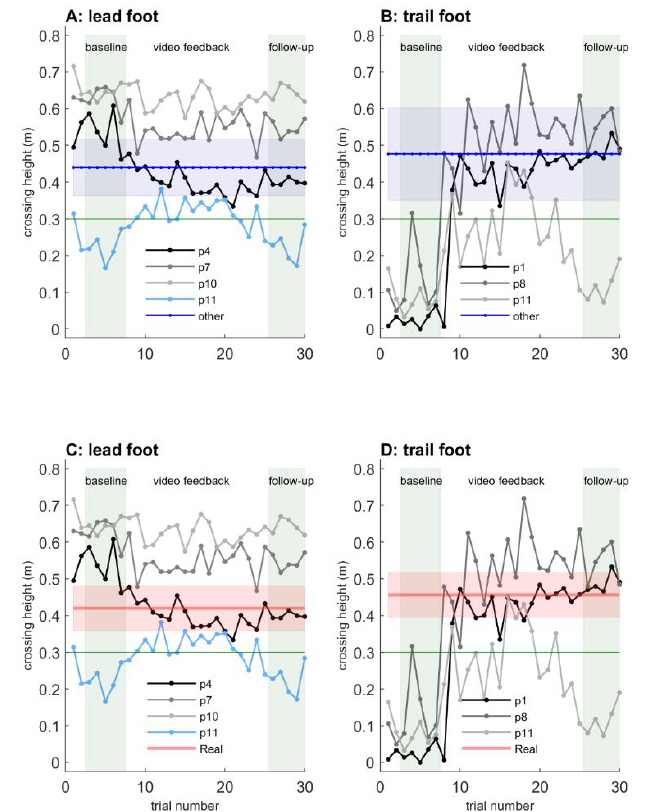
Figure 8. Crossing heights for lead ( A and C ) and trail ( B and D ) foot at holographic hurdle 1 (0.3 m height, marked as horizontal green line), focusing on the participants identified in Experiment 1 with dissimilar crossing maneuvers between real and holographic obstacles (Panels A and C: participants 4, 7, and 11 with extreme lead-foot margins; Panels B and D: participants 1, 8, and 11 without trail foot adjustments). The baseline and follow-up blocks of trials are marked by transparent gray boxes. Trial 8 is the first trial after the participant viewed mixed-reality video feedback. Trial 1 and 2 are familiarization trials. The blue transparent patches (Panels A and B) represent the 95% confidence interval of all trials of the nine participants with similar crossing maneuvers for real and holographic obstacles. The red transparent patches (in Panels C and D) represent the 95% confidence interval of all 30 real obstacle-avoidance trials of the three participants identified with dissimilar crossing maneuvers between real and holographic obstacles. Individual data falling outside these bands may be considered to deviate from, respectively, holographic obstacle crossing heights for participants with similar crossing maneuvers for real and holographic obstacles (blue band) and the real obstacle crossing heights for the participants identified with dissimilar crossing maneuvers between real and holographic obstacles (red